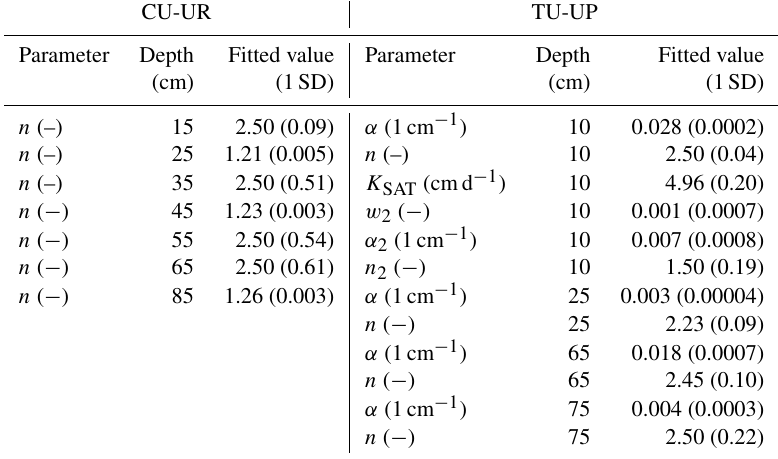
Table 2. Fitted soil hydraulic parameters. The optimal model fit is given with 1 standard deviation (SD). This table shows the parameters that were found to be sensitive and were fitted. The rest of the parameters were set to initial values as per Table S4 for numerical modeling.